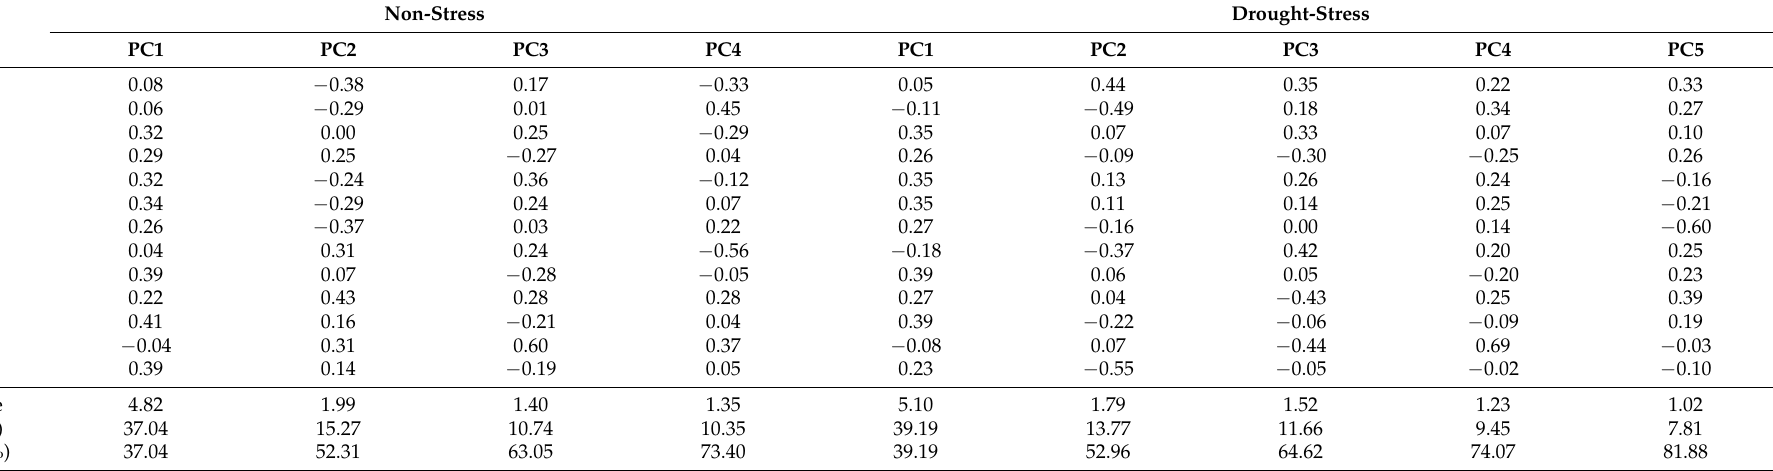
Table 2. Rotated component matrix for 13 yield components and root attributes in 100 wheat genotypes assessed under drought-stressed and non-stressed